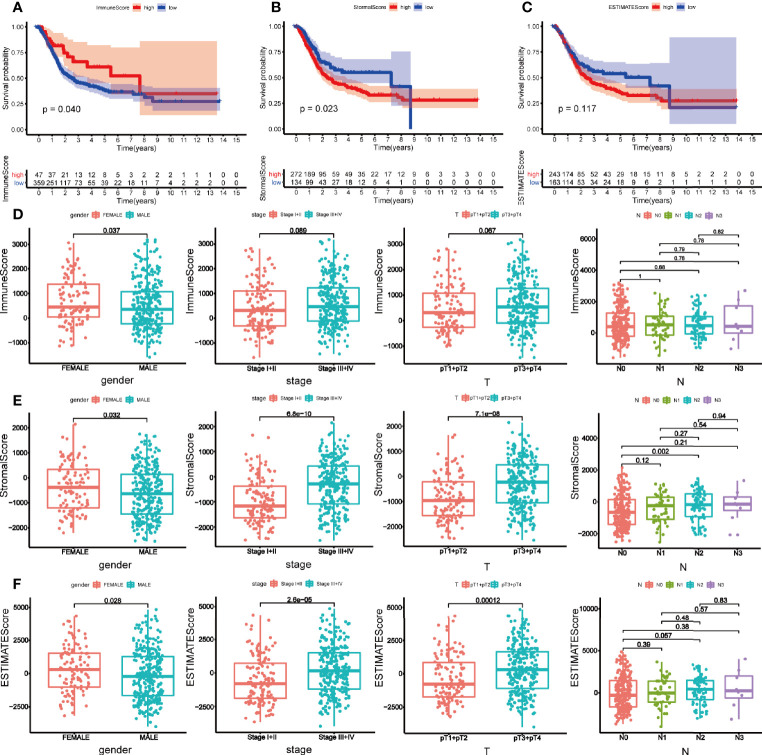
Survival analysis and clinical correlation analysis of immune, stromal, and estimated score. Kaplan-Meier analysis for overall survival of bladder cancer patients based on immune score (A), stromal score (B), and estimated score (C). (D) The correlations between immune score and gender, clinical stage, pT, and N stage. (E) The correlations between stromal score and gender, clinical stage, pT, and N stage. (F) The correlations between estimated score and gender, clinical stage, pT, and N stage. P-value < 0.05 was deemed to be significant.